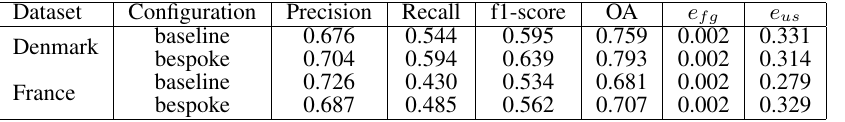
Table 1. Prediction accuracy assessment of the Mask R-CNN trained with different configurations on the two datasets.